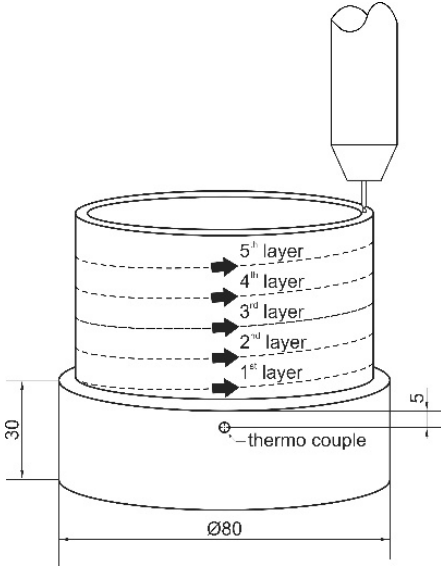
Table 2. Applied GMAW parameters for processing of tool steel X36 specimens.